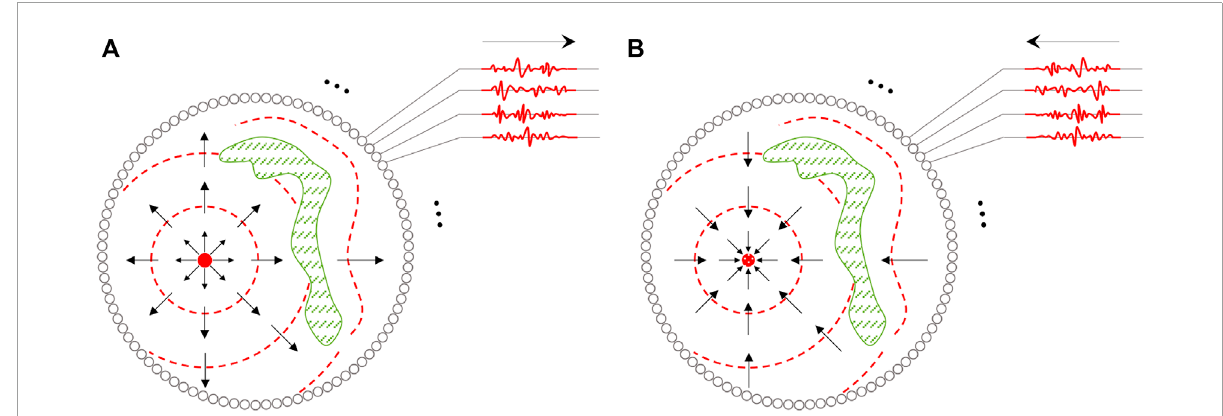
FIGURE 1 Two-dimensional illustration of a time-reversal cavity for (A) forward-propagation stage: recording step and (B) backward-propagation stage: reconstructing step [adopted from Fink (1992)].